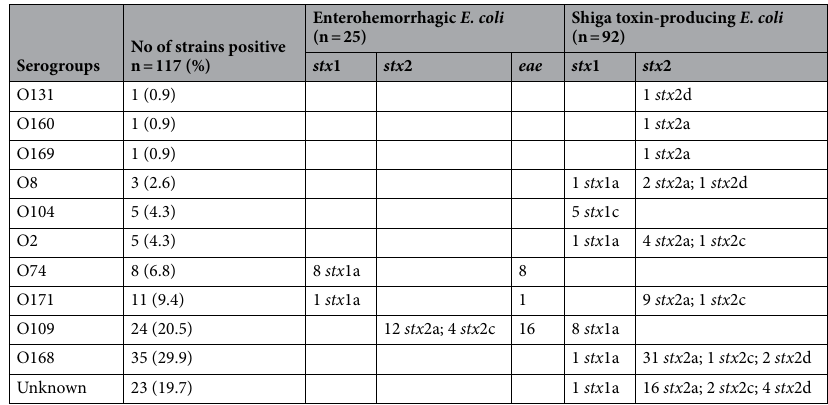
Table 1. Detection of serogroups, virulence genes, and Shiga toxin gene subtypes in Shiga toxin-producing Escherichia coli strains (n = 117) isolated from feedlot cattle feces from one commercial feedlot by multiplex PCR assays (2013